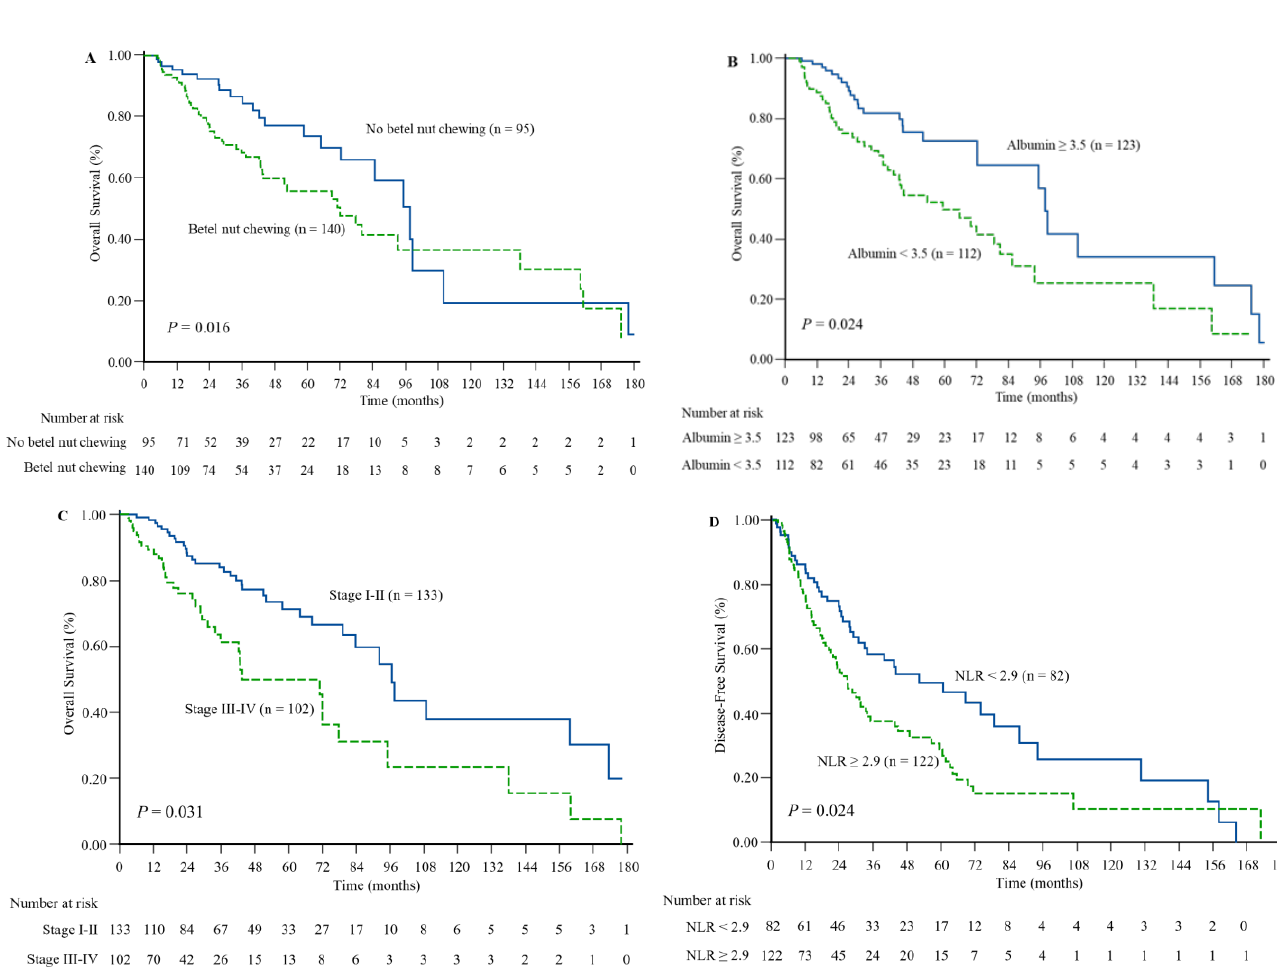
Figure 3. Kaplan–Meier estimates of survival outcomes. Prediction of overall survival based on betel nut chewing ( A ), albumin status ( B ), and tumor stage ( C ). Prediction of disease-free survival based on neutrophil-to-lymphocyte ratio (NLR) ( D ).